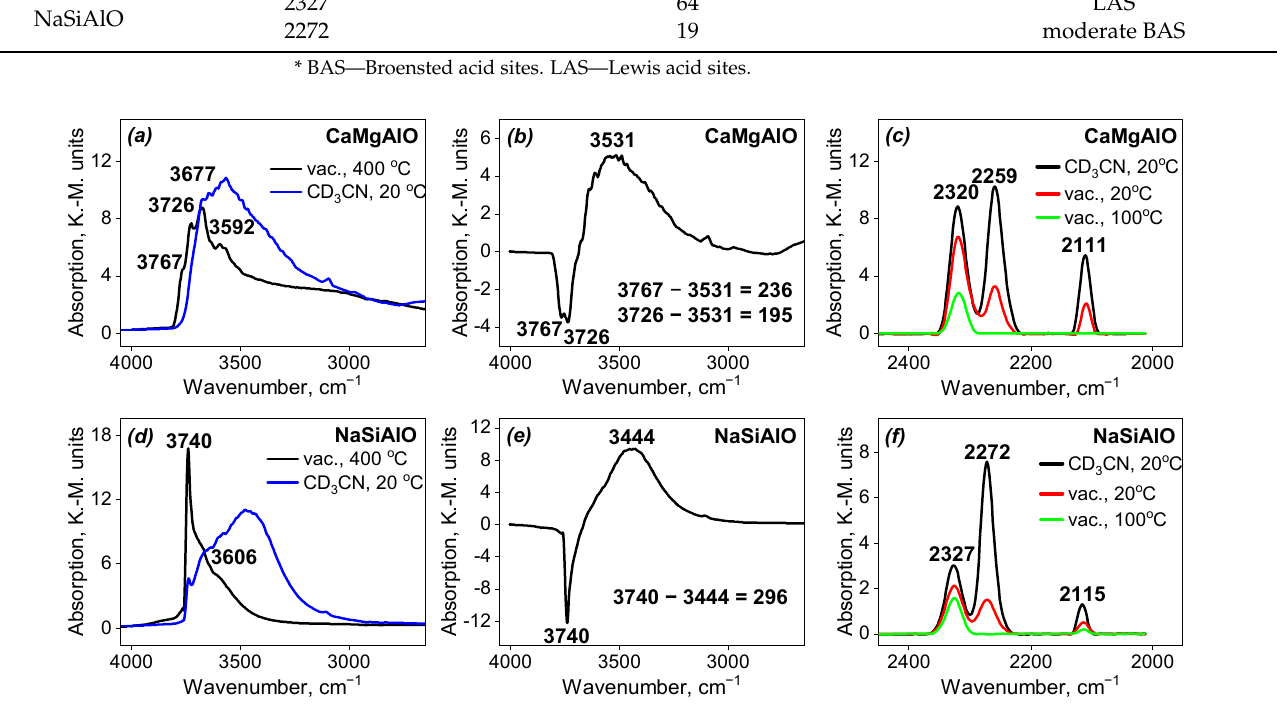
Table 4. The atomic concentrations of the elements on the surface of non-reduced rhodium-loaded catalysts by XPS.